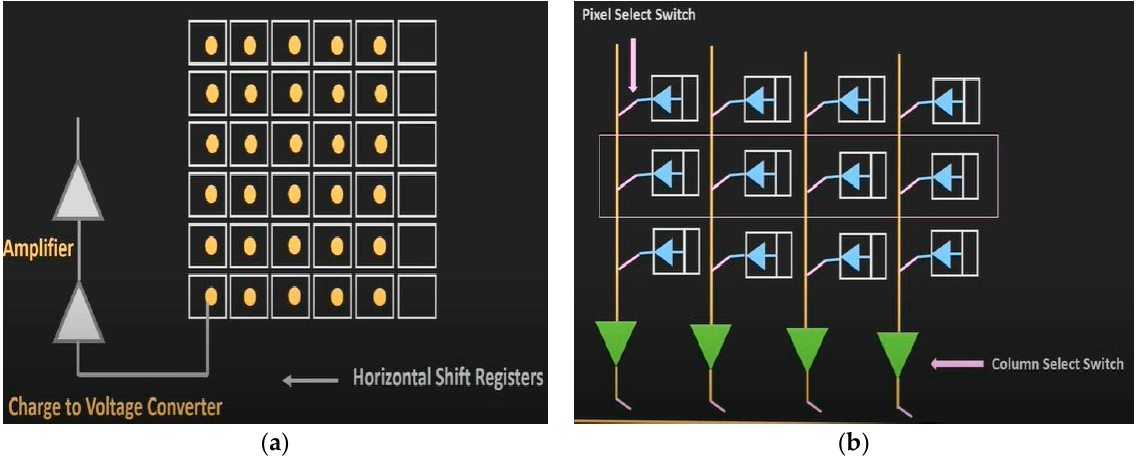
Figure 13. ( a ) ISO Invariant Sony Camera at different ISOs; ( b ) exposure compensated for in post- processing.